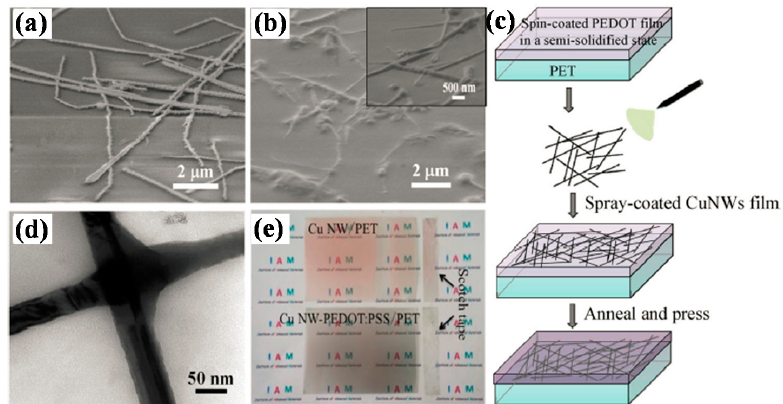
Figure 9. SEM images of ( a ) Cu NWs/PET and ( b ) Cu NWs–PEDOT:PSS/PET films; ( c ) Preparation procedure for Cu NWs–PEDOT:PSS/PET films; ( d ) TEM image of PEDOT:PSS-coated Cu NWs; ( e ) Photographs of adhesion test for Cu NWs/PET and Cu NWs–PEDOT:PSS/PET films. Reproduced with permission from [87]; published by Springer, 2015.